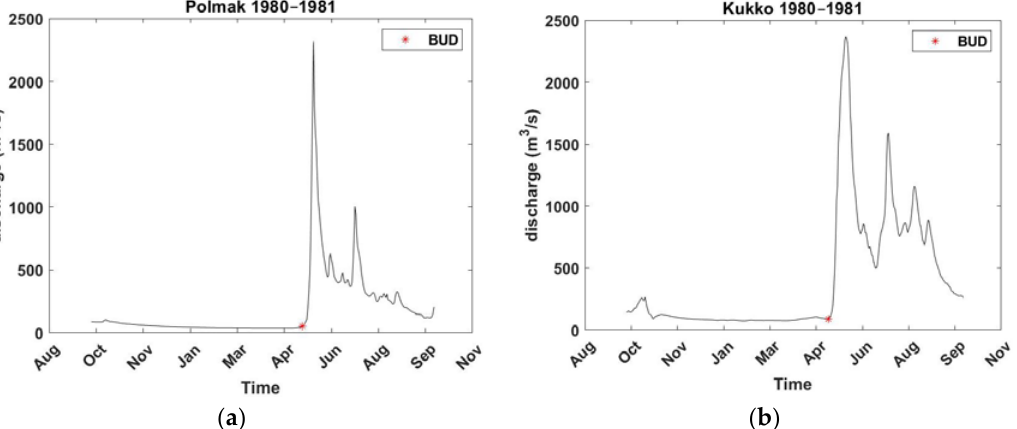
Figure 2. ( a ) Break-up detection in Polmak, Tana River; ( b ) break-up detection in Kukkolankoski, Tornio River. The break-up detection results are available in Supplementary Materials Figures S1 and S2 folders.